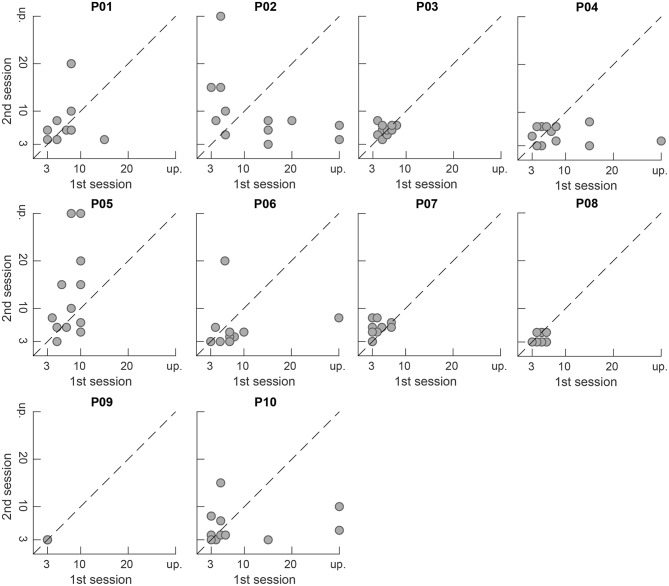
Preferred number of retained components in the second session plotted vs. the preferred number in the first session per participant. Points close to the dashed diagonal line indicate equal ratings in the first and second presentation of a piece. Unprocessed signals are denoted by “up”.